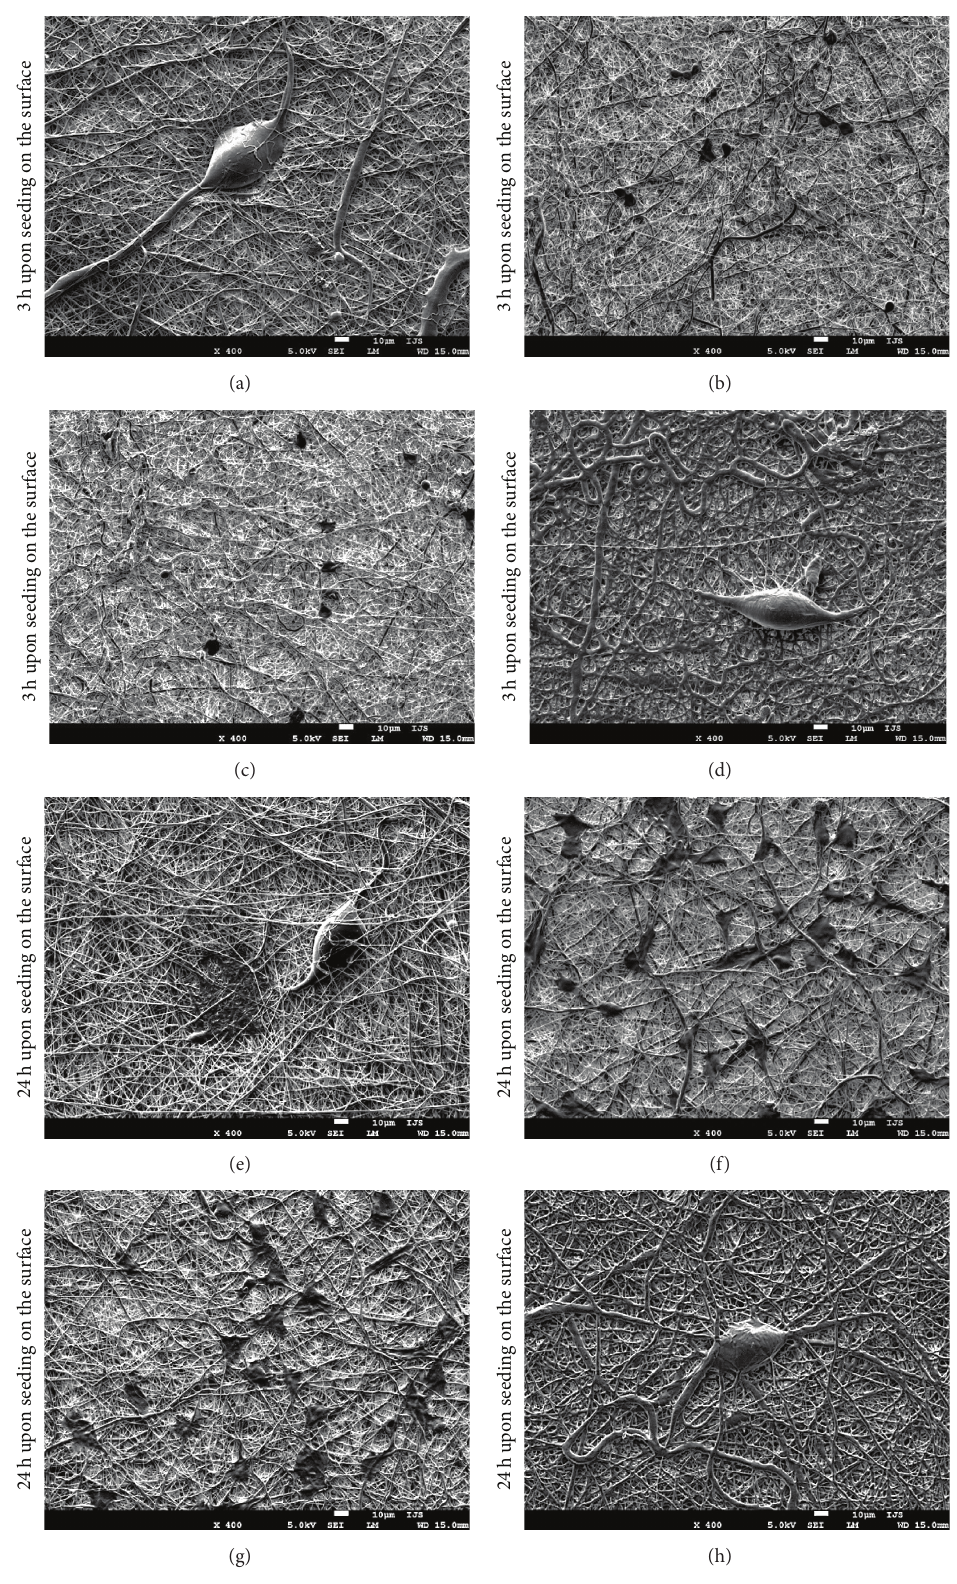
Figure 3: SEM images of plasma-treated PCL samples with adhered HUVEC 3 and 24h upon seeding: (a, e) untreated, (b, f) treated in O 2 plasma, (c, g) treated in NH 3 plasma, and (f, h) treated in SO 2